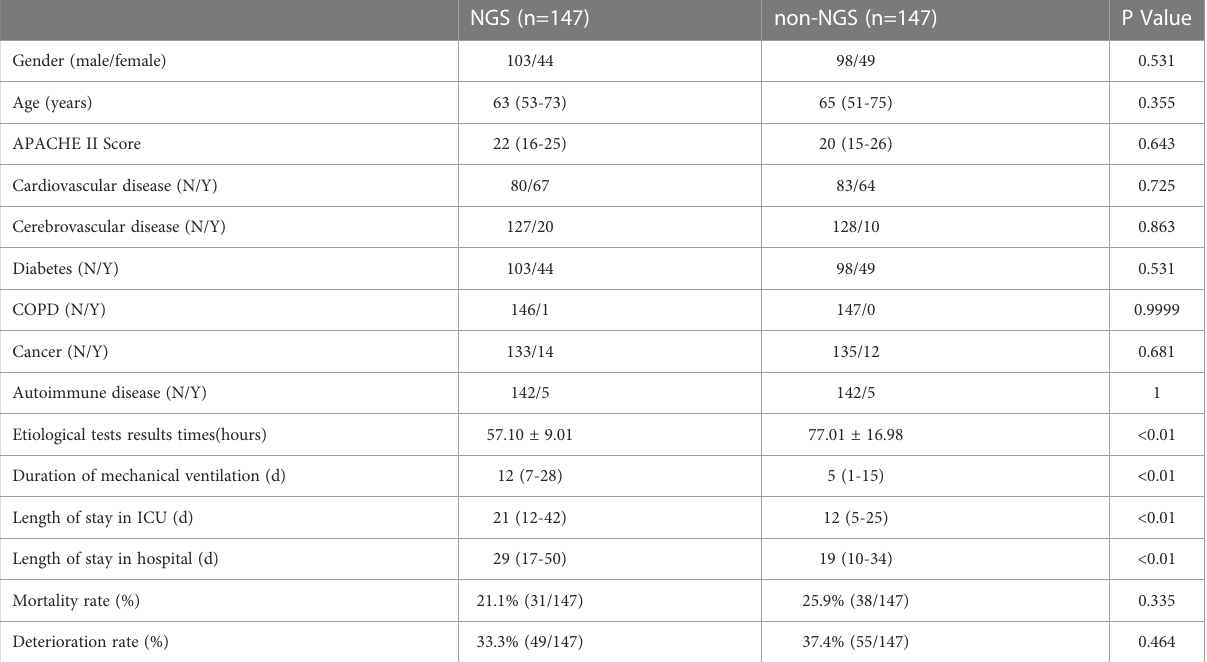
TABLE 2 Baseline characteristics and clinical indices of NGS and non-NGS groups after PSM balancing.